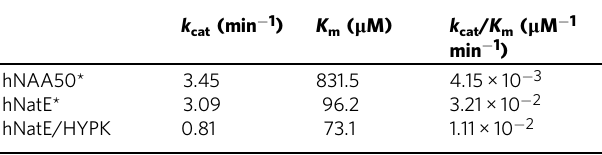
Table 1 Catalytic parameters for hNAA50, hNatE, and